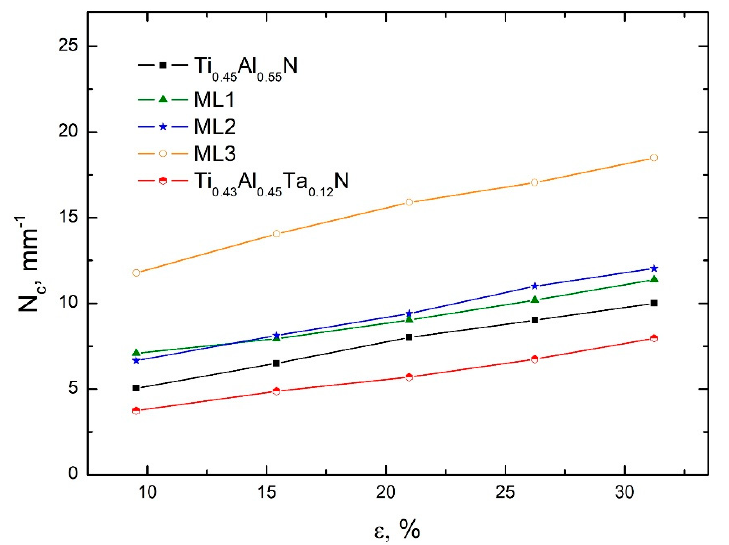
Figure 5. Density of diagonal cracks in the coatings subjected to uniaxial tension as a function of substrate elongation.